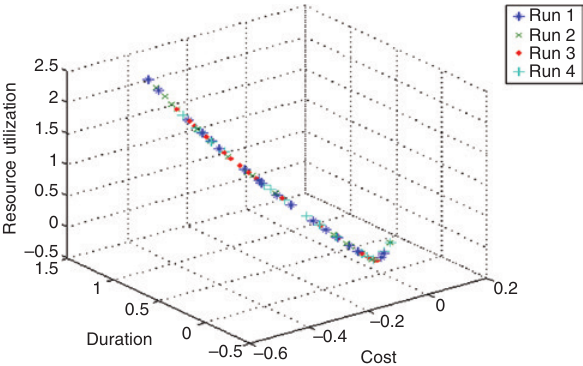
Figure 2: MOGA Resource Optimization Pareto Front of All